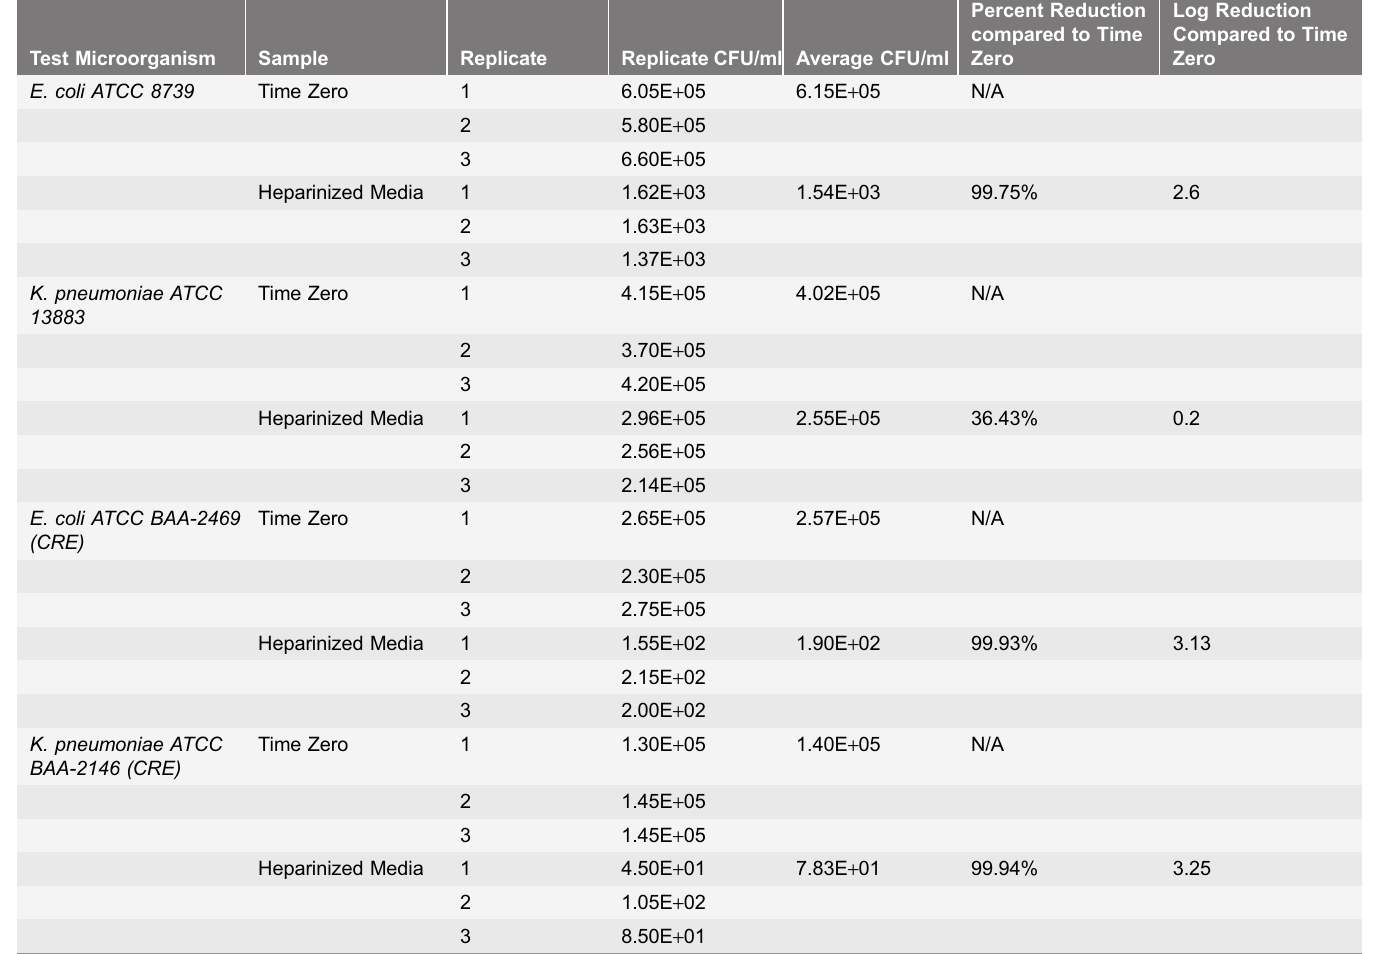
Table 1. Removal of sensitive and CRE bacteria by heparinized beads.